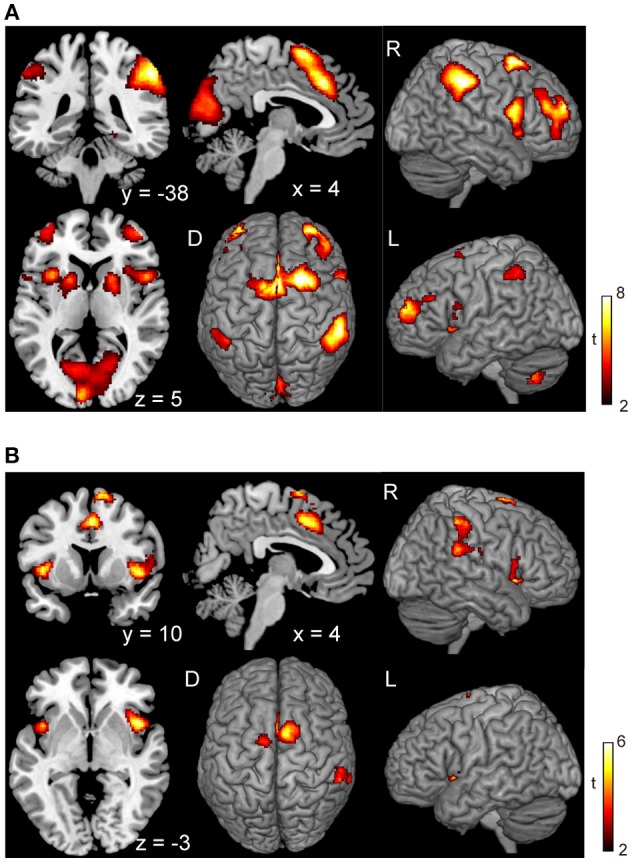
Conjunction analysis maps of the brain activations related to the planning of motor actions and the exact inhibition conduct of finger tapping. Peak activations in the conjunction analysis map for the planning of motor action between waiting condition and tapping condition (A) and peak activations in the map between the voluntary stop condition and forced stop condition (B) are shown. The height and extent thresholds of brain activation were set at the P < 0.001 level (uncorrected) and a cluster-level FWE of 0.05, respectively. The scale for t-scores is shown alongside. The number and alphabetic characters indicate the XYZ coordinates in the Montreal Neurological Institute (MNI) space. The letters in the figure indicate the direction of each brain image (L, left; R, right; D, dorsal).